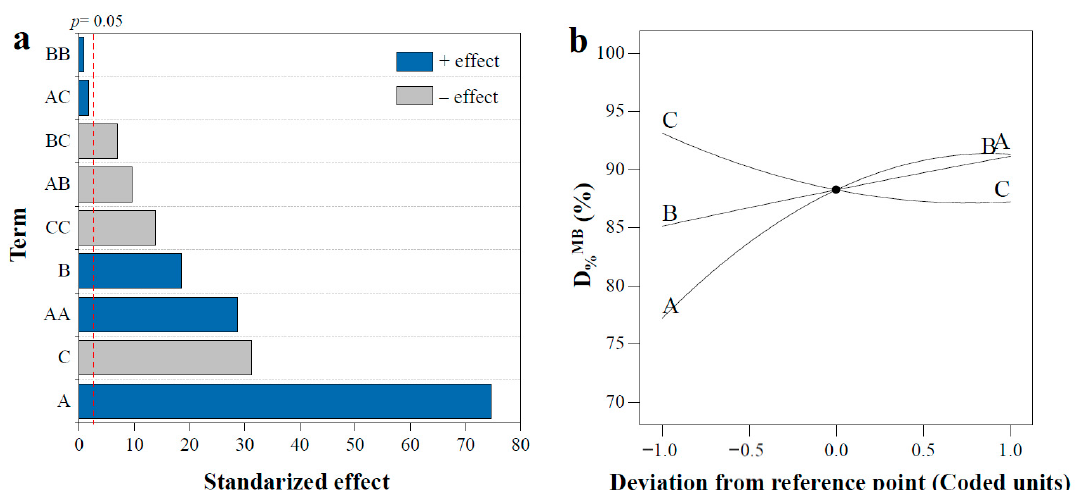
Figure 2. ( a ) Pareto chart showing the standardized e ff ects of variables (first order, quadratic and interaction terms) on D %MB (vertical line represents the 95% confidence interval), and ( b ) Perturbation graphs for D % MB (A-[H 2 O 2 ] / [Fe 2 + ], B-[Fe 2 + ], C-pH).